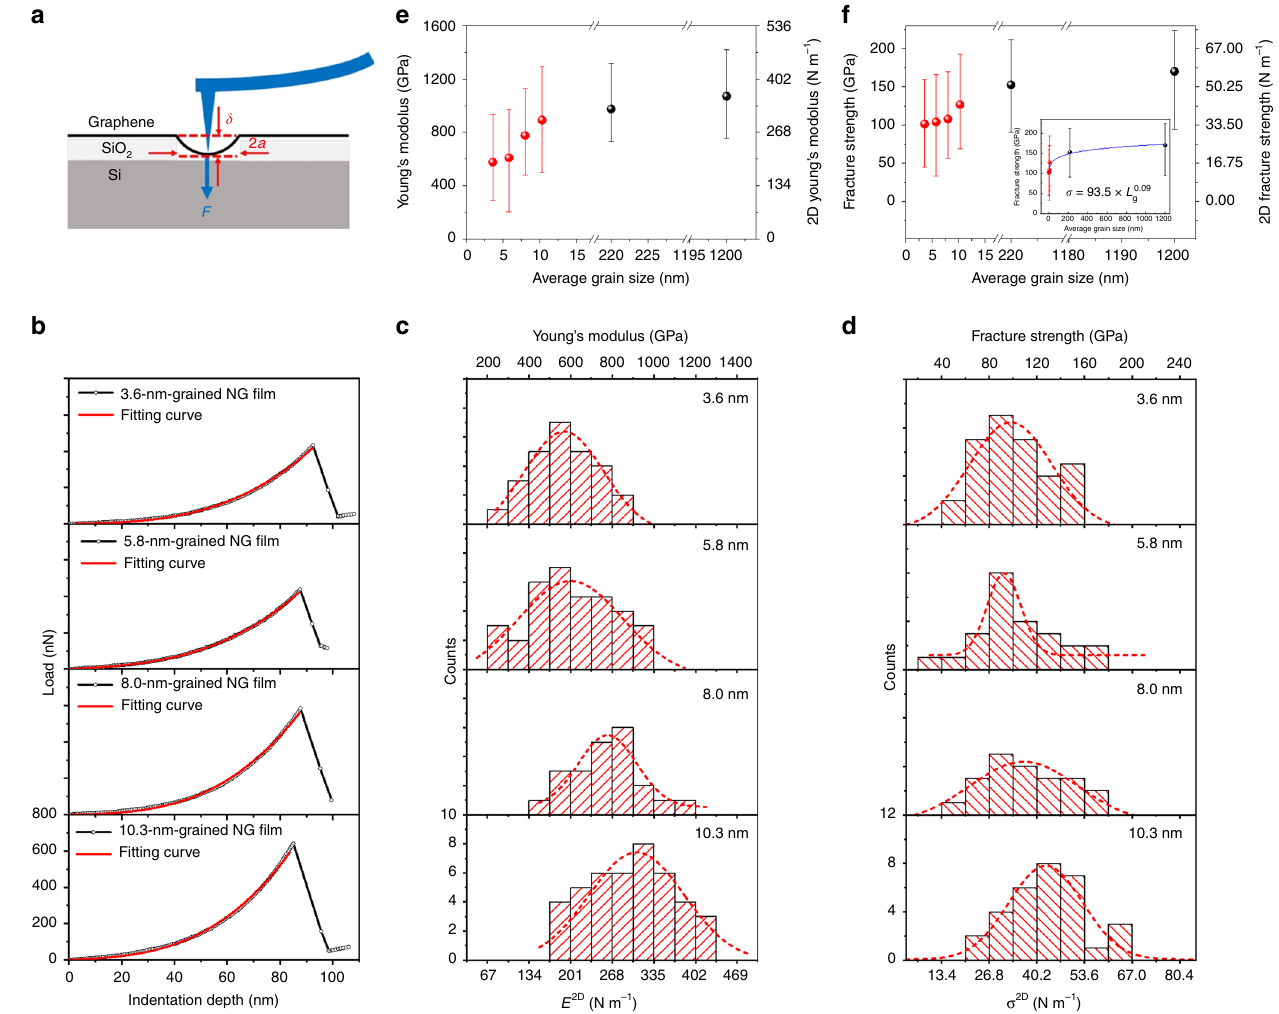
Fig. 5 Mechanical properties of NG fi lms. a Schematic of nanoindentation on a suspended NG fi lm. b Representative force-displacement curves of the 3.6, 5.8, 8.0, and 10.3 nm-grained NG fi lms in AFM nanoindentation. The red lines are fi tting curves to Eq. 1. c , d The histograms of the Young ’ s modulus c and fracture strength d of 3.6, 5.8, 8.0, and 10.3 nm-grained NG fi lms. The dashed lines indicate the fi tted Gaussian distributions. e , f The Young ’ s modulus e and fracture strength f as a function of grain size. The blue line in the inset of f is a fi t to the experimental data, which gives a fi tted equation σ = 93.5 × L 0.09 . Here, the diameter (1.2 μ m) of the holes in mechanical property measurements was used as the grain size of single-crystal graphene domains even g though the real gain size is ~1 mm. The error bars in e and f show the variation of the Young ’ s modulus and fracture strength,